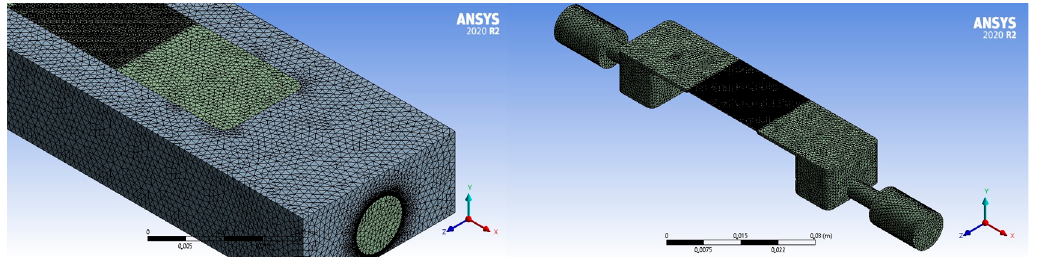
Figure 5. Grid view with fl uid domain on the right side.